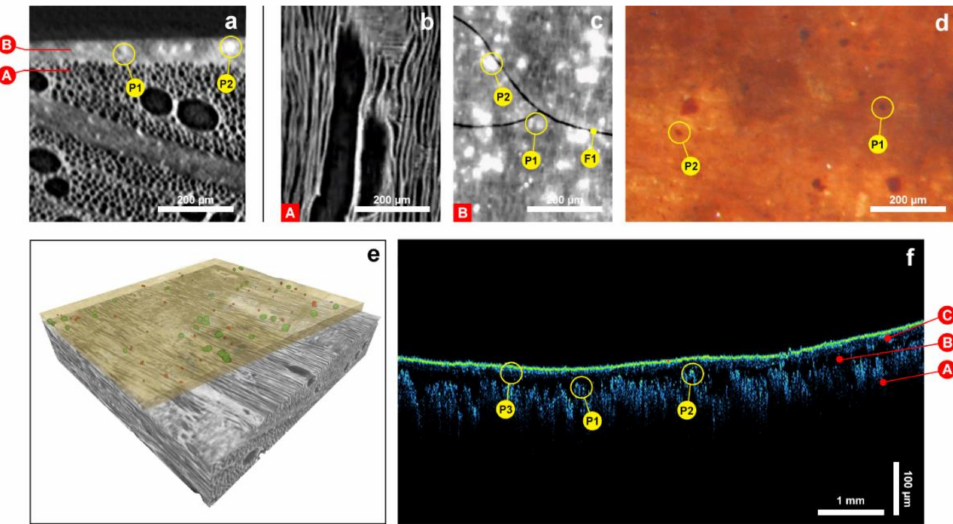
Figure 5. Fragment F16, Gasparo da Sal ò . ( a ) Transverse slice from the SR-micro-CT volume with the identified layers; different layers are highlighted in capital letters and different particles are indicated as P1 and P2. ( b , c ) Radial slices from the SR-micro-CT volume showing the finishing layers discussed in the text and reporting the particles P1 and P2 indicated in ( a ) and identified at different depth. Cracks are indicated as F1. ( d ) Stereomicroscopic image of the surface showing the different particles P1 and P2, embedded in the finishing layer. ( e ) Virtual reconstruction based on SR-micro-CT volume. The varnish layer (B in Figure 5a) is colored in yellow, whereas Pb-based particles and red-ochre particles embedded in the varnish are colored in red and green, respectively. ( f ) OCT tomogram presented in false-color scale (see Section 2.2 for details). The wood substrate A, the varnish layer B, and the external layer C are shown. Particles embedded in the varnish layer and in the external layer are indicated as P1, P2, and P3,